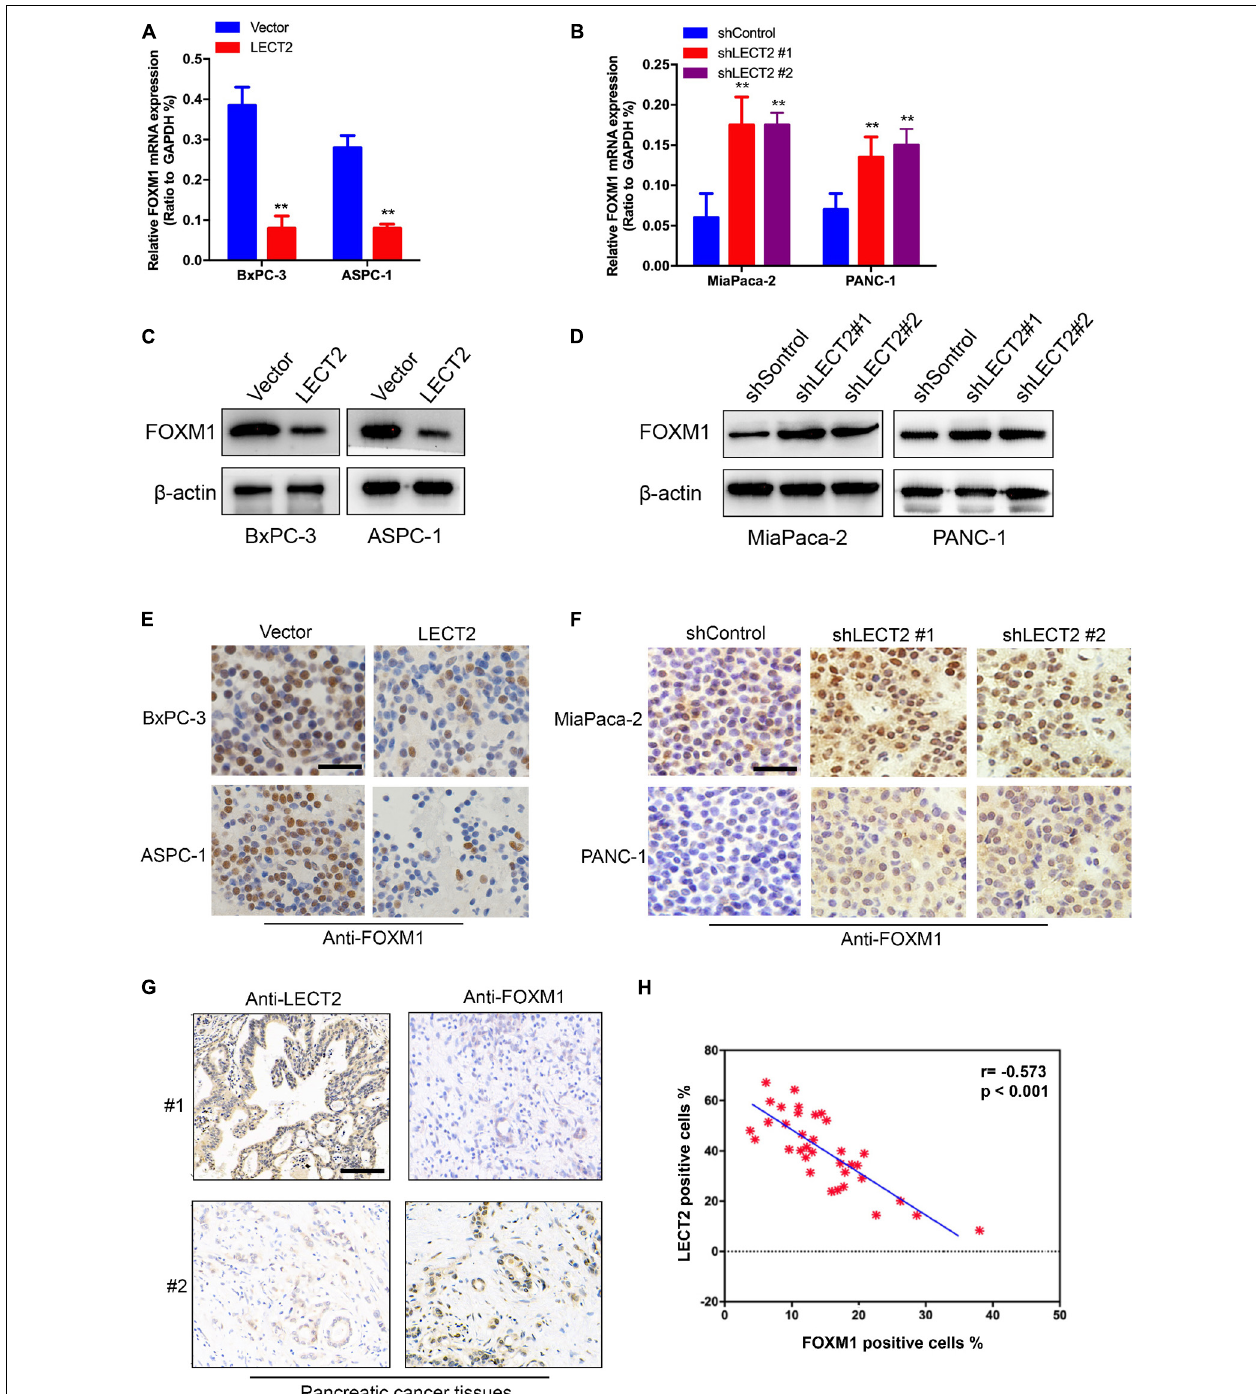
FIGURE 6 | LECT2 downregulates FOXM1 expression. (A) mRNA expression of FOXM1 in BxPC-3 and ASPC-1 cells transfected with control (blue) or LECT2 (red) vector. (B) mRNA expression of FOXM1 in MiaPaca-2 and Panc-1 cells transfected with shControl (blue) or shLECT2 (red and magenta) vector. (C) Immunoblotting to measure FOXM1 protein levels in BxPC-3 (left) and ASPC-1 (right) cells described in (A) . (D) Immunoblotting to measure FOXM1 protein levels in MiaPaca-2 (left) and Panc-1 (right) cells described in (B) . (E) Representative IHC staining images of FOXM1 in BxPC-3 (top) and ASPC-1 (bottom) cells described in (A) . (F) Representative IHC staining images of FOXM1 protein levels in MiaPaca-2 (top) and Panc-1 (bottom) cells described in (B) . (G) Representative IHC staining images of LECT2 and FOXM1 in pancreatic cancer tissues from 2 patients. (H) Quantification of (G) . Scale bar = 400 µ m in (E,F) . Scale bar = 200 µ m in (G) . ** p < 0 .